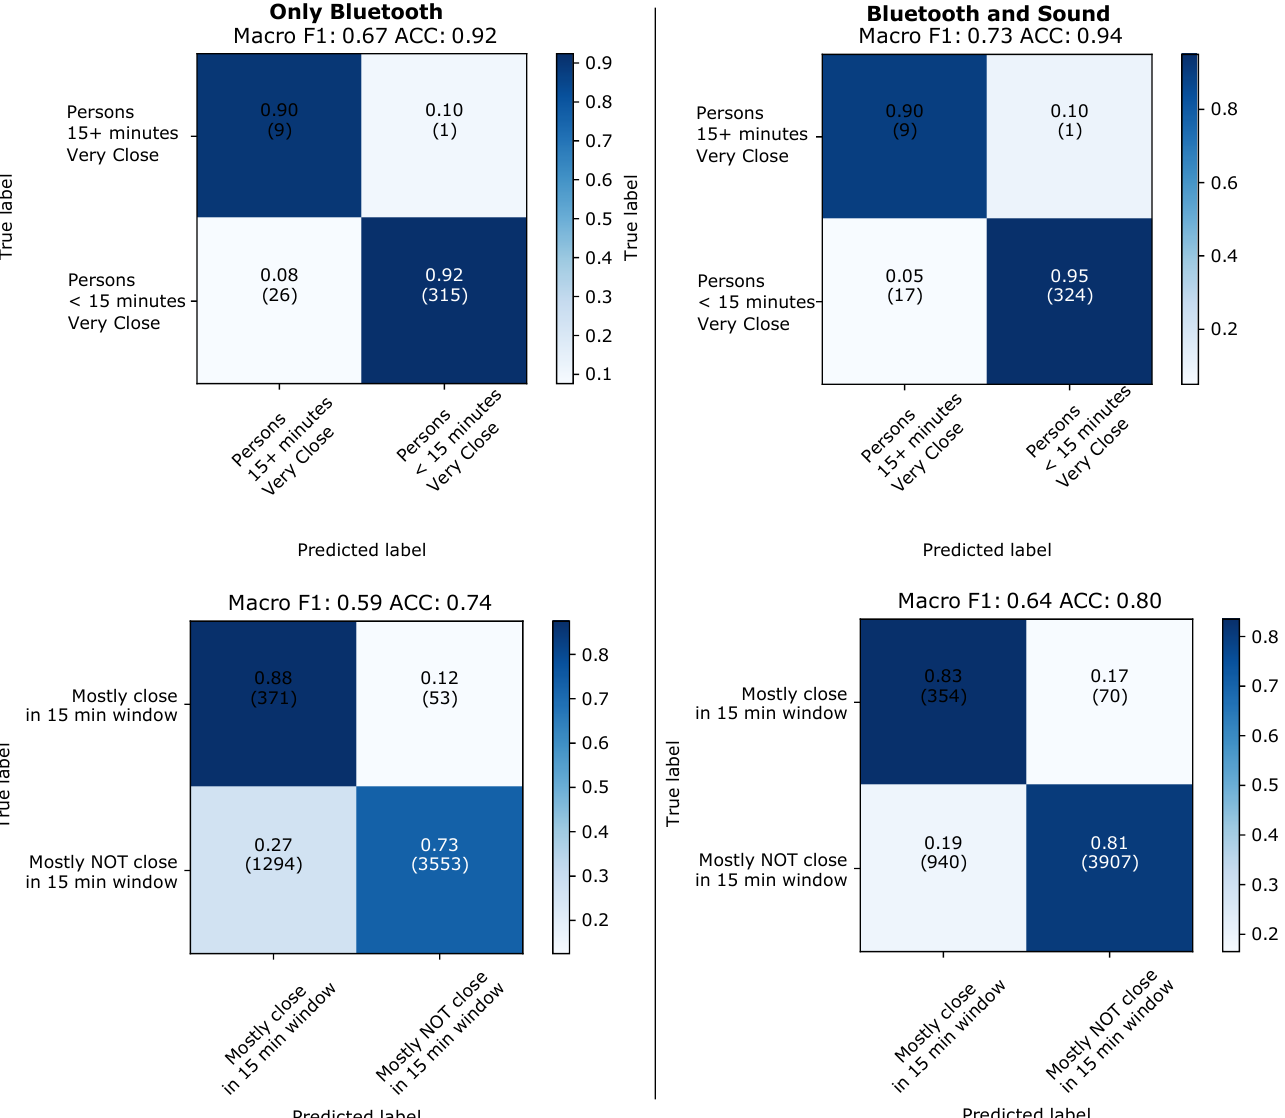
Figure 17. Leaving-one-day-out. Comparing people that can be detected being close for 15 min or more using different